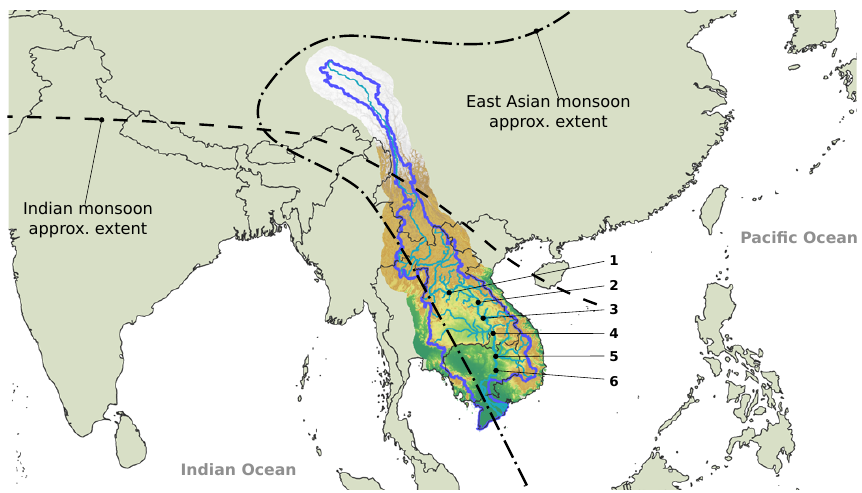
Fig. 1. Asian monsoon regions. Mekong River, its basin and the location of the gauging stations used in this study are shown. The approximate East Asia-Western North Pacific monsoon and Indian monsoon extents were taken from Holmes et al. (2009). The stations used in this study were Vientiane (1), Thakhek (2), Mukdahan (3), Pakse (4), Stung Treng (5) and Kratie